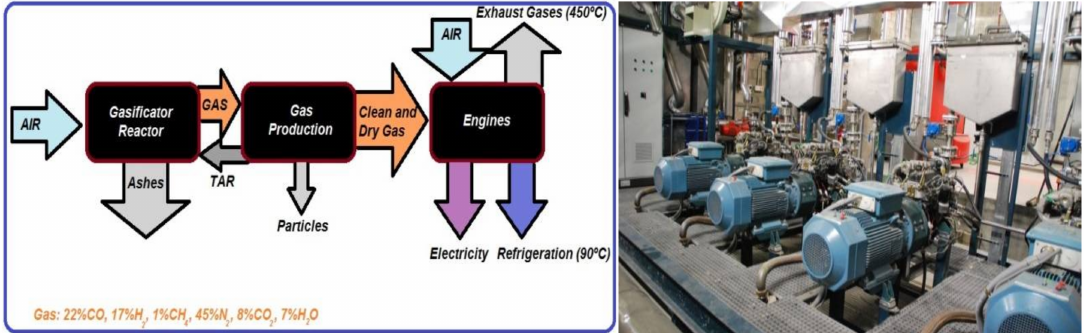
Figure 4. Tri-generation system through biomass